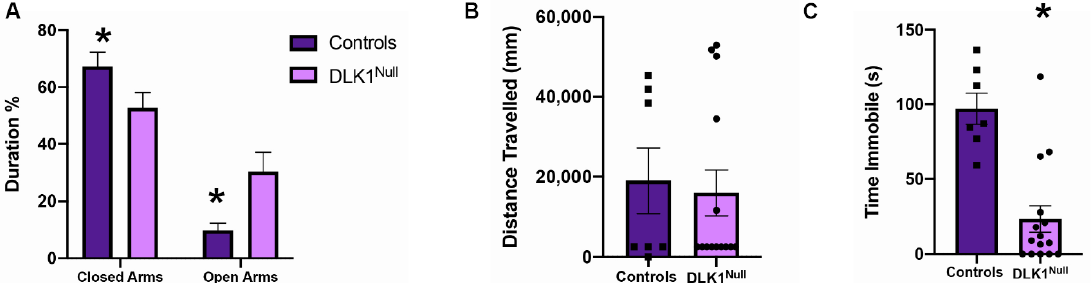
Figure 7. DLK1-deletion in the LHA decreases anxiety and depression-like behavior in mice. Figure 7 ( A ) Percentage of time spent in open and closed arms of the elevated plus maze. * p < 0.05 by one-way ANOVA. ( B ) Average distance traveled (mm) in the open field boxes over 24 min (3–27 min). This period was chosen to exclude the initial and final minutes, during which the experimenter was leaving / entering the testing room, as this activity could have disturbed the mice and their activity. ( C ) Time (s) spent immobile during the forced swim test, * p < 0.05 by Student’s t -test. Control n = 7, DLK1 Null =